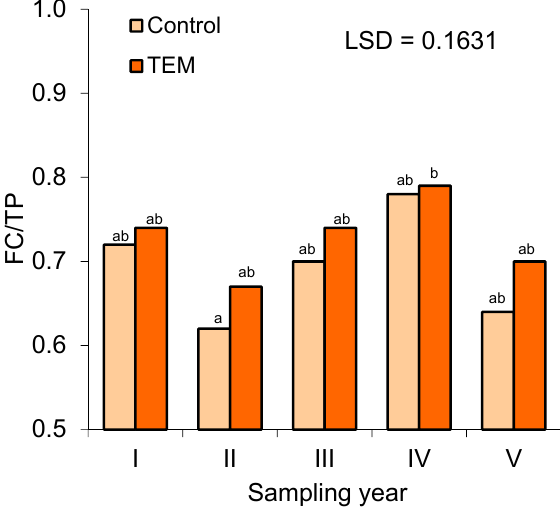
Figure 7. The annual mean values of the FC / TP ratio during the five-year study. Notes: Control: soil without EM-A ( n = 150), TEM: soil with EM-A application ( n = 150), I–V: study year. Each letter (a, ab and b) means a significant di ff erence (Control or TEM × study year) according to Tukey’s lowest significant di ff erence